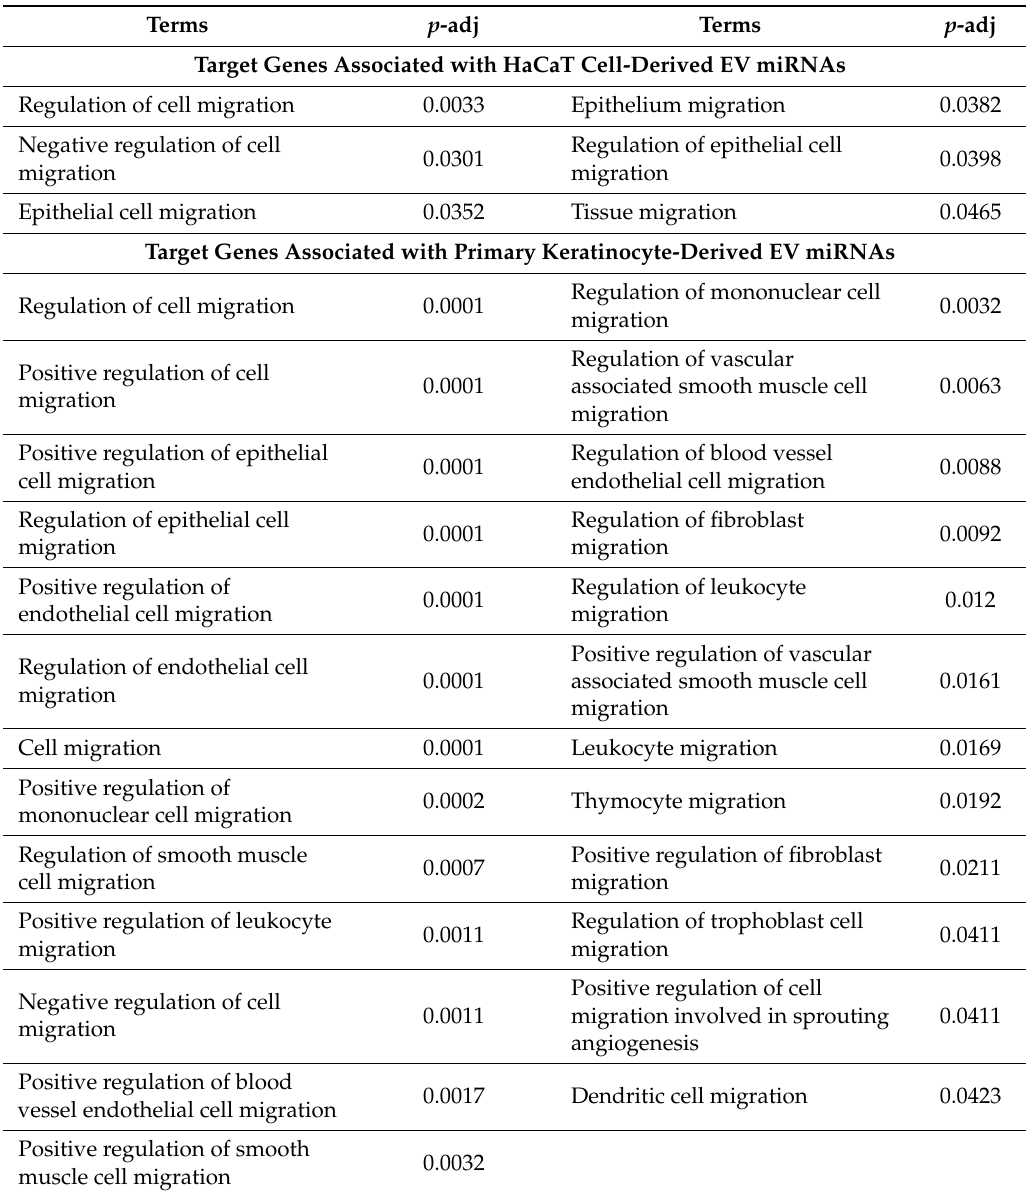
Table 5. BP terms related to